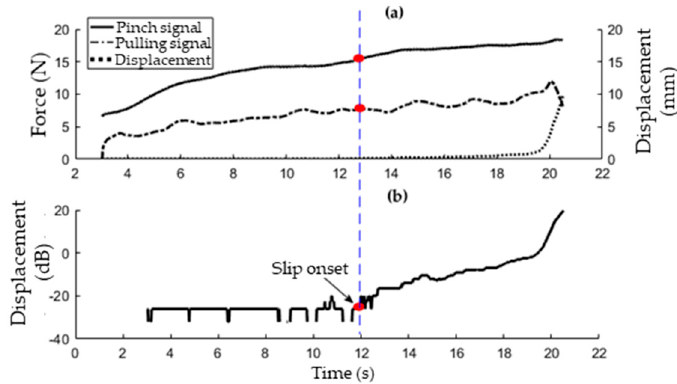
Figure 11. ( a ) One trial recorded from one volunteer; and ( b ) displacement in decibel scale.